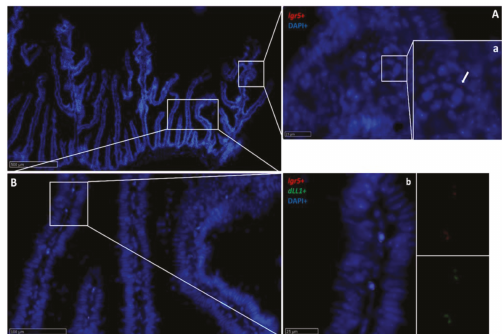
Figure 16. In situ hybridization of lgr5 and dll1 mRNA in the second segment of the rainbow trout mid-intestine. Lgr5 (red dots) expression was low at the complex fold apex ( A , a ): higher magnification, arrow) and more intense at the base of the complex folds and in the rest of the second segment of the mid-intestine ( B , b ): higher magnification). The two genes were expressed in a few cells found along the villus connective axis ( b ).